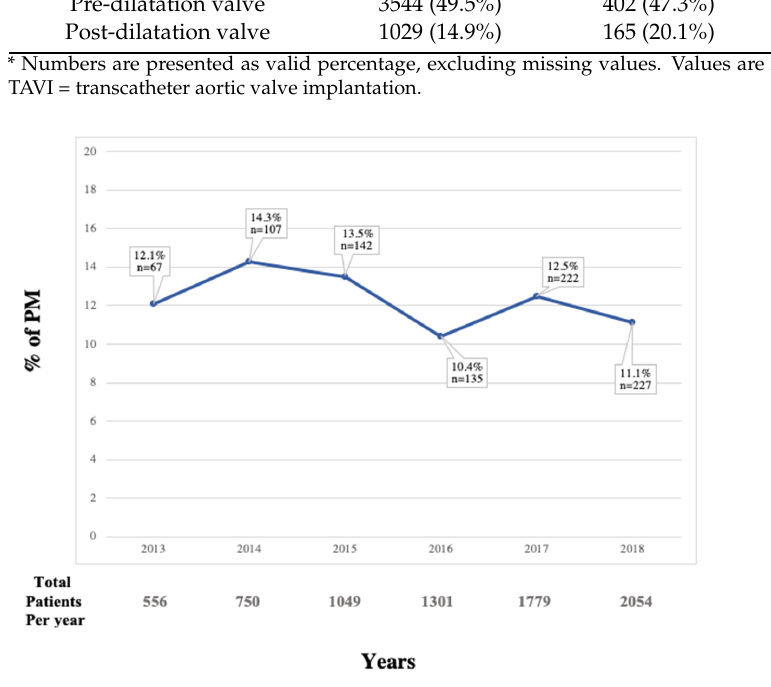
Figure 2. Trends of permanent pacemaker (PM) implementation after transcatheter aortic valve implantation (TAVI) over time.